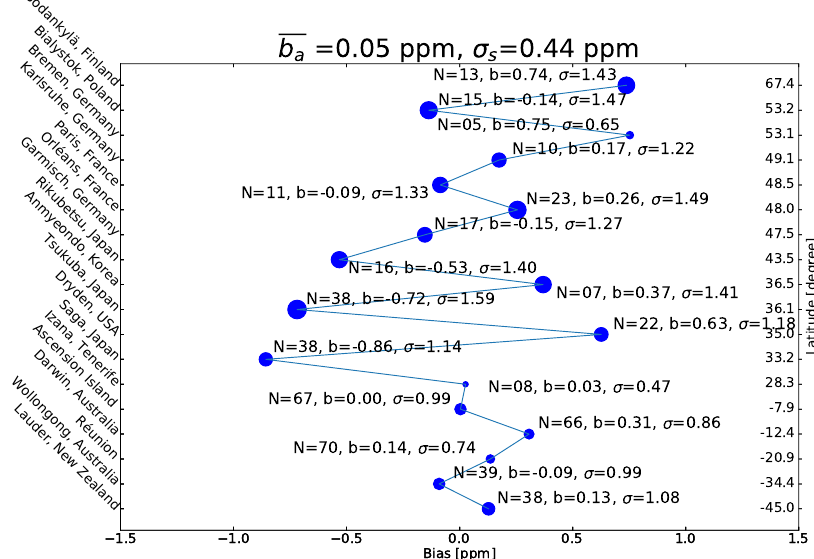
Figure 10. Same as Fig. 8, but for OCO-2 ocean type measurements obtained under glint